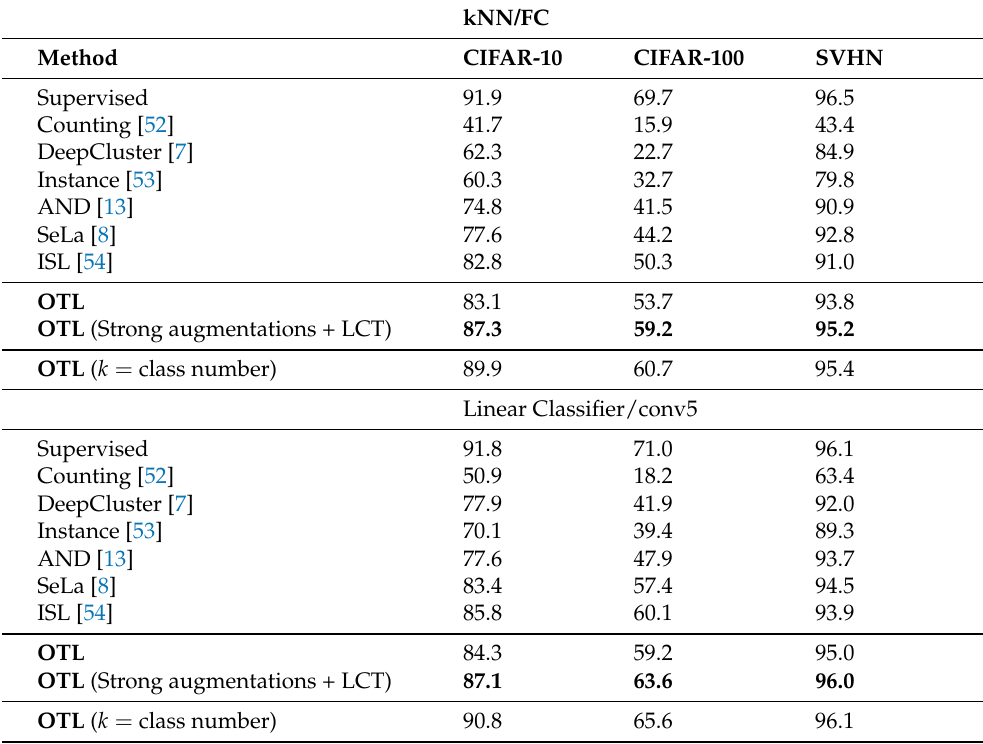
Table 1. Evaluations on AlexNet (OTL = our new method). The best results are highlighted by the bold.